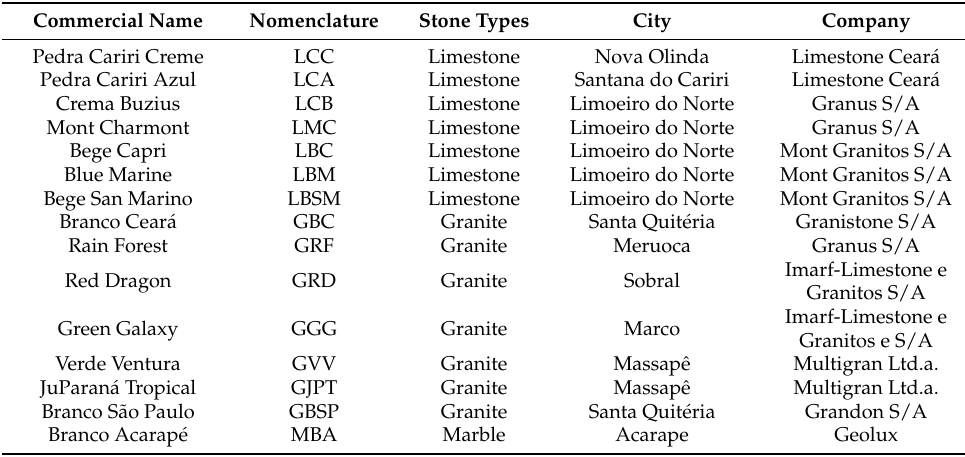
Table 1. The commercial name, nomenclature used in this work, type of natural stone, location of extraction, and supplier